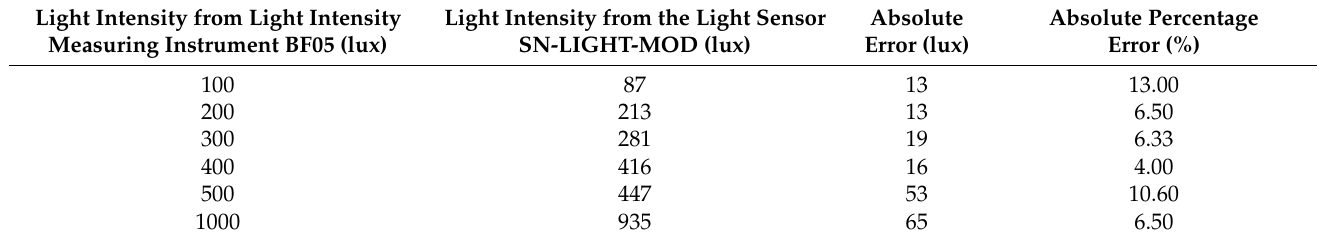
Table 1. Comparison of light intensity between BF05 lux meter and (SN-LIGHT-MOD) light sensor. Light Intensity from Light Intensity